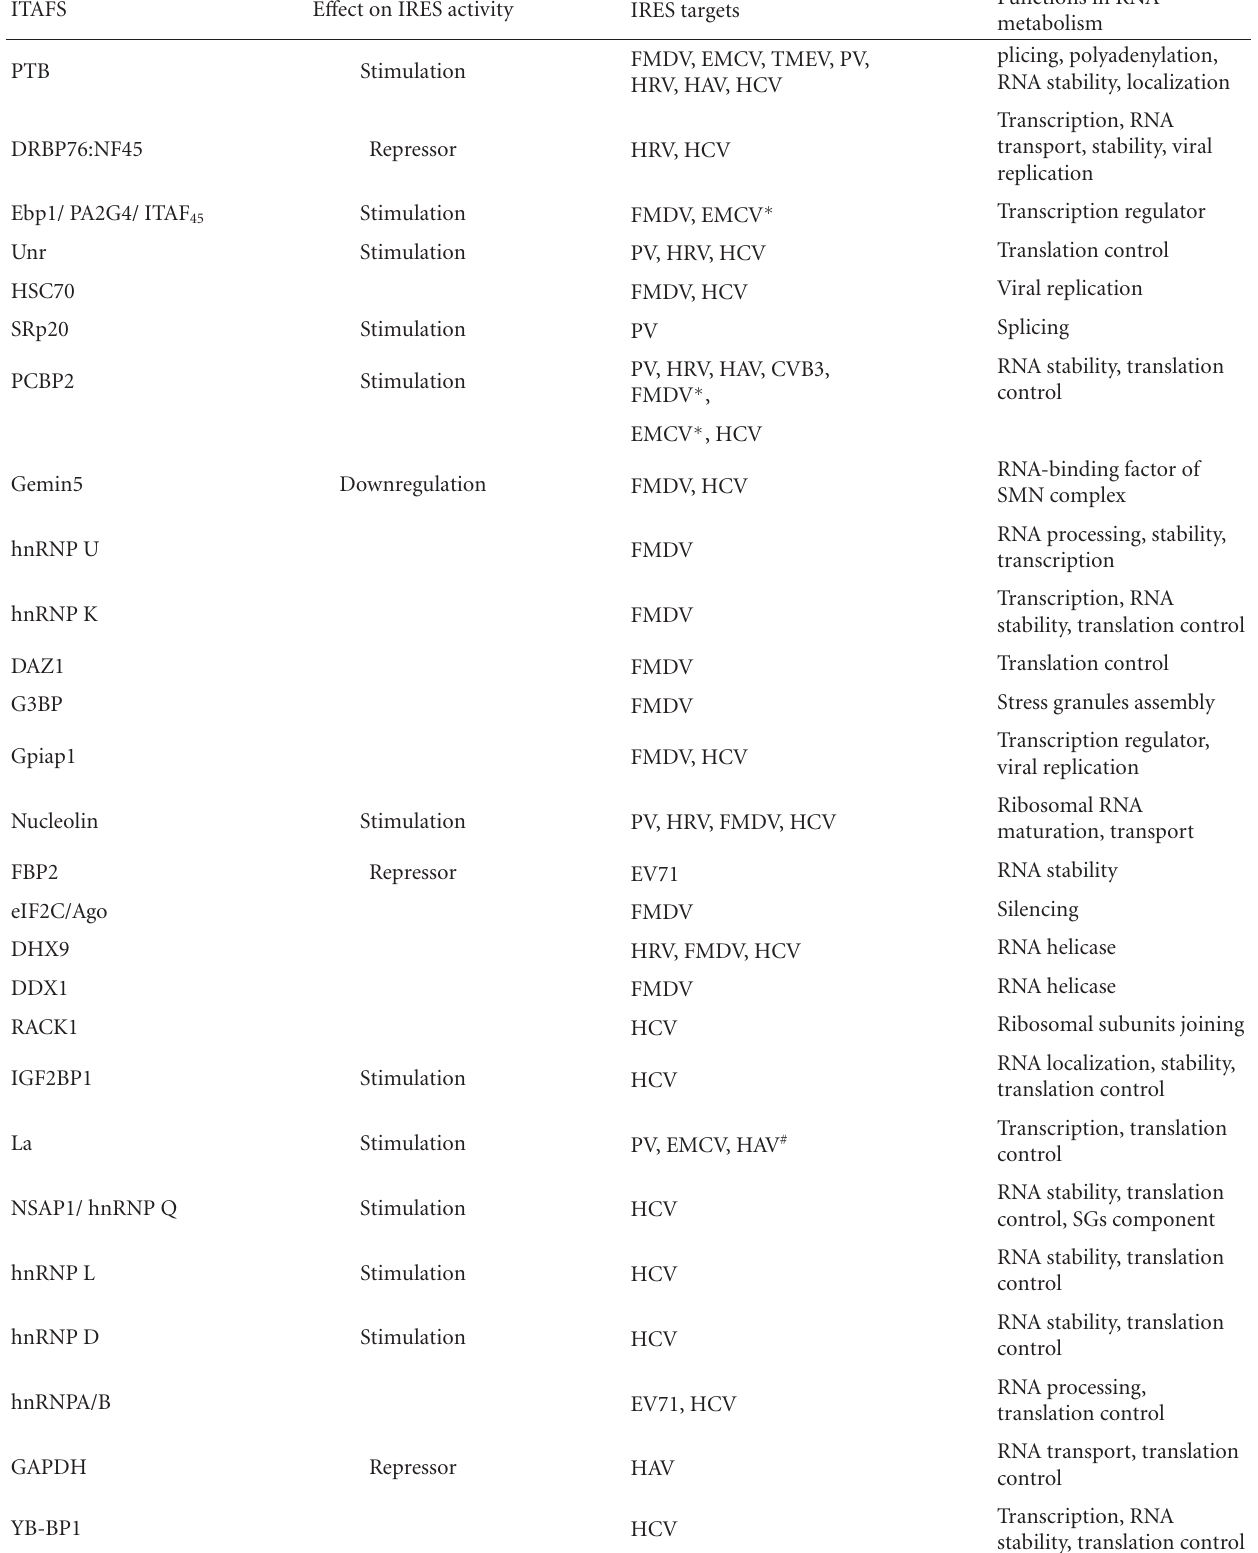
Table 1: RNA-binding proteins interacting with viral